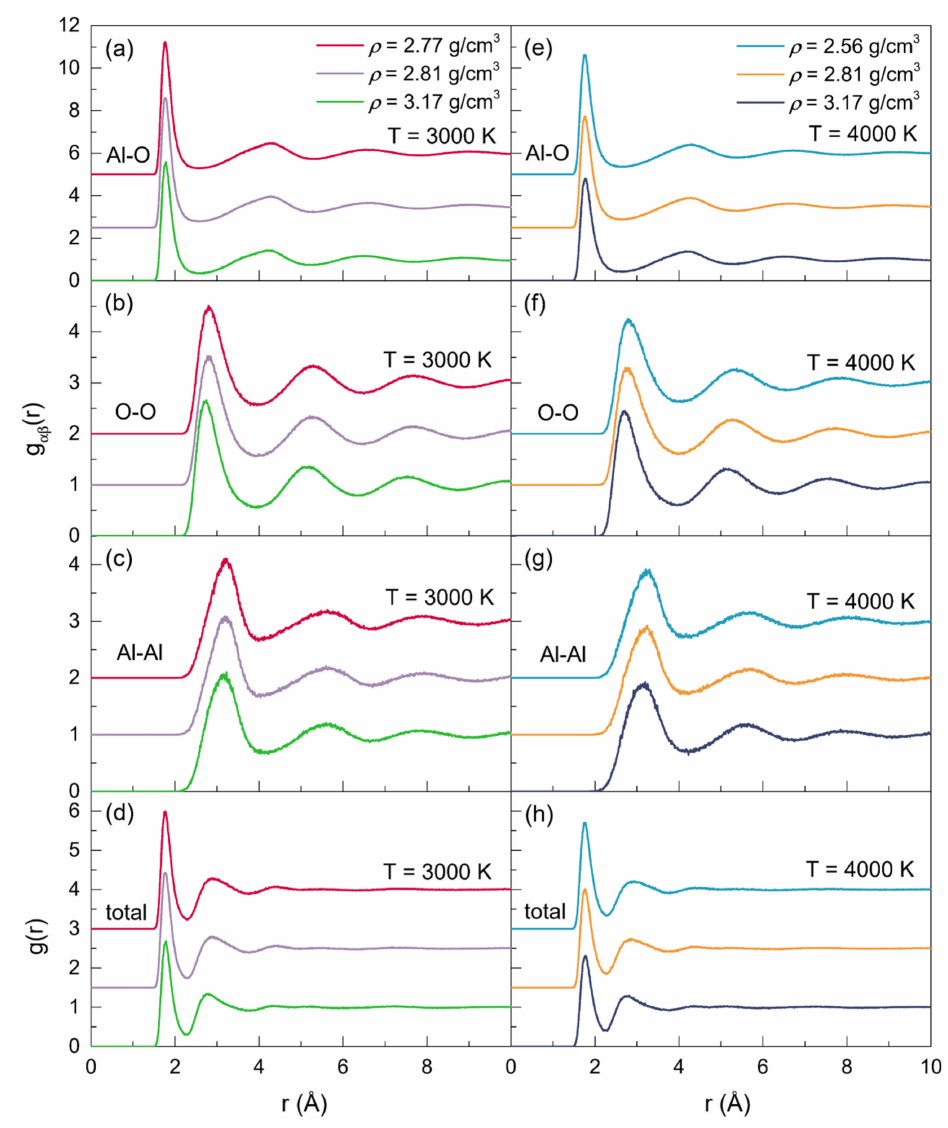
Figure 2. Partial and total pair distribution functions for the configurations of liquid alumina with three densities, respectively, at 3000 K and 4000